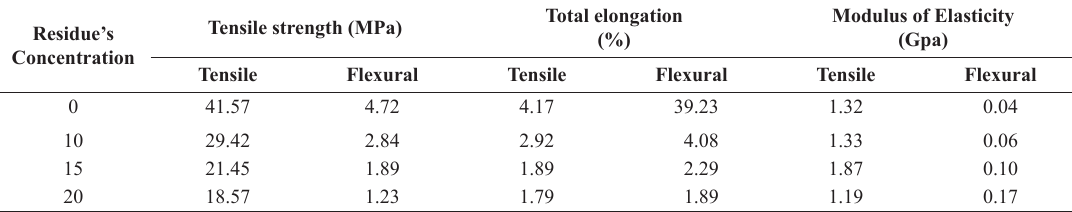
Table 2. Test results of tensile and flexural. Residue’s Concentration